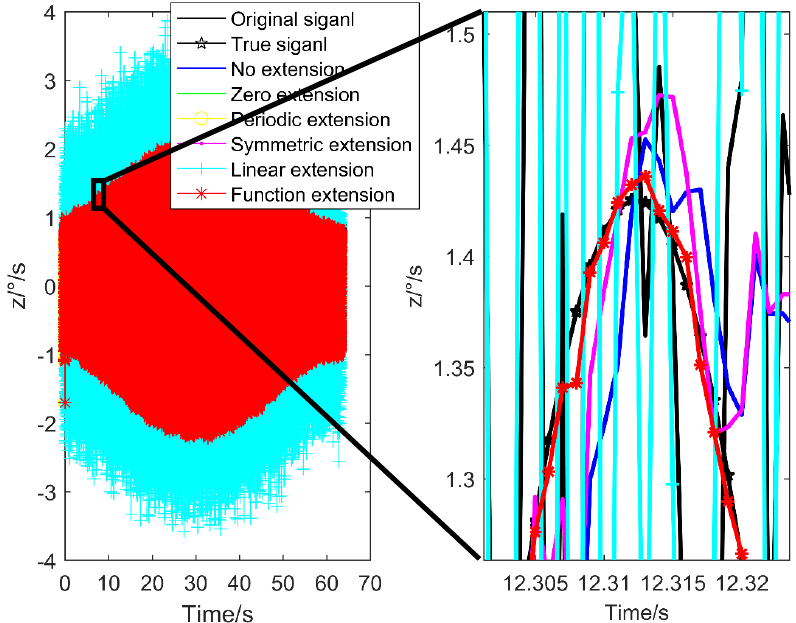
Figure 9. De-noising results of different extension methods.